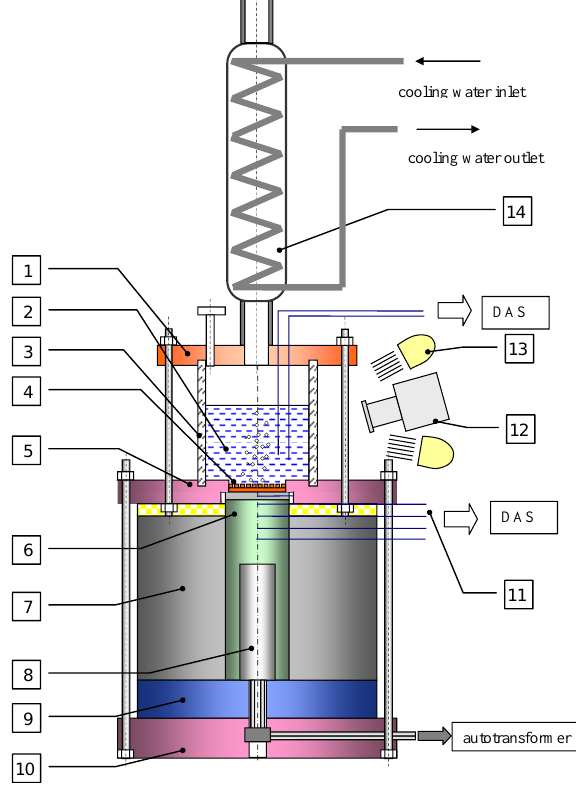
Fig. 2. Pool boiling measurement stand: 1 – digital camera, 2 – Teflon casing, 3 – compensating leads, 4 – data logger, 5 – dry- well calibrator, 6 – insulation, 7 – glass vessel, 8 – boiling liquid, 9 – investigated specimen, 10 – copper bar with cartridge heater, 11 – condenser, 12 – wattmeter, 13 – PC, 14 – power supply and fuses, 15 – autotransformer, 16 – lights.